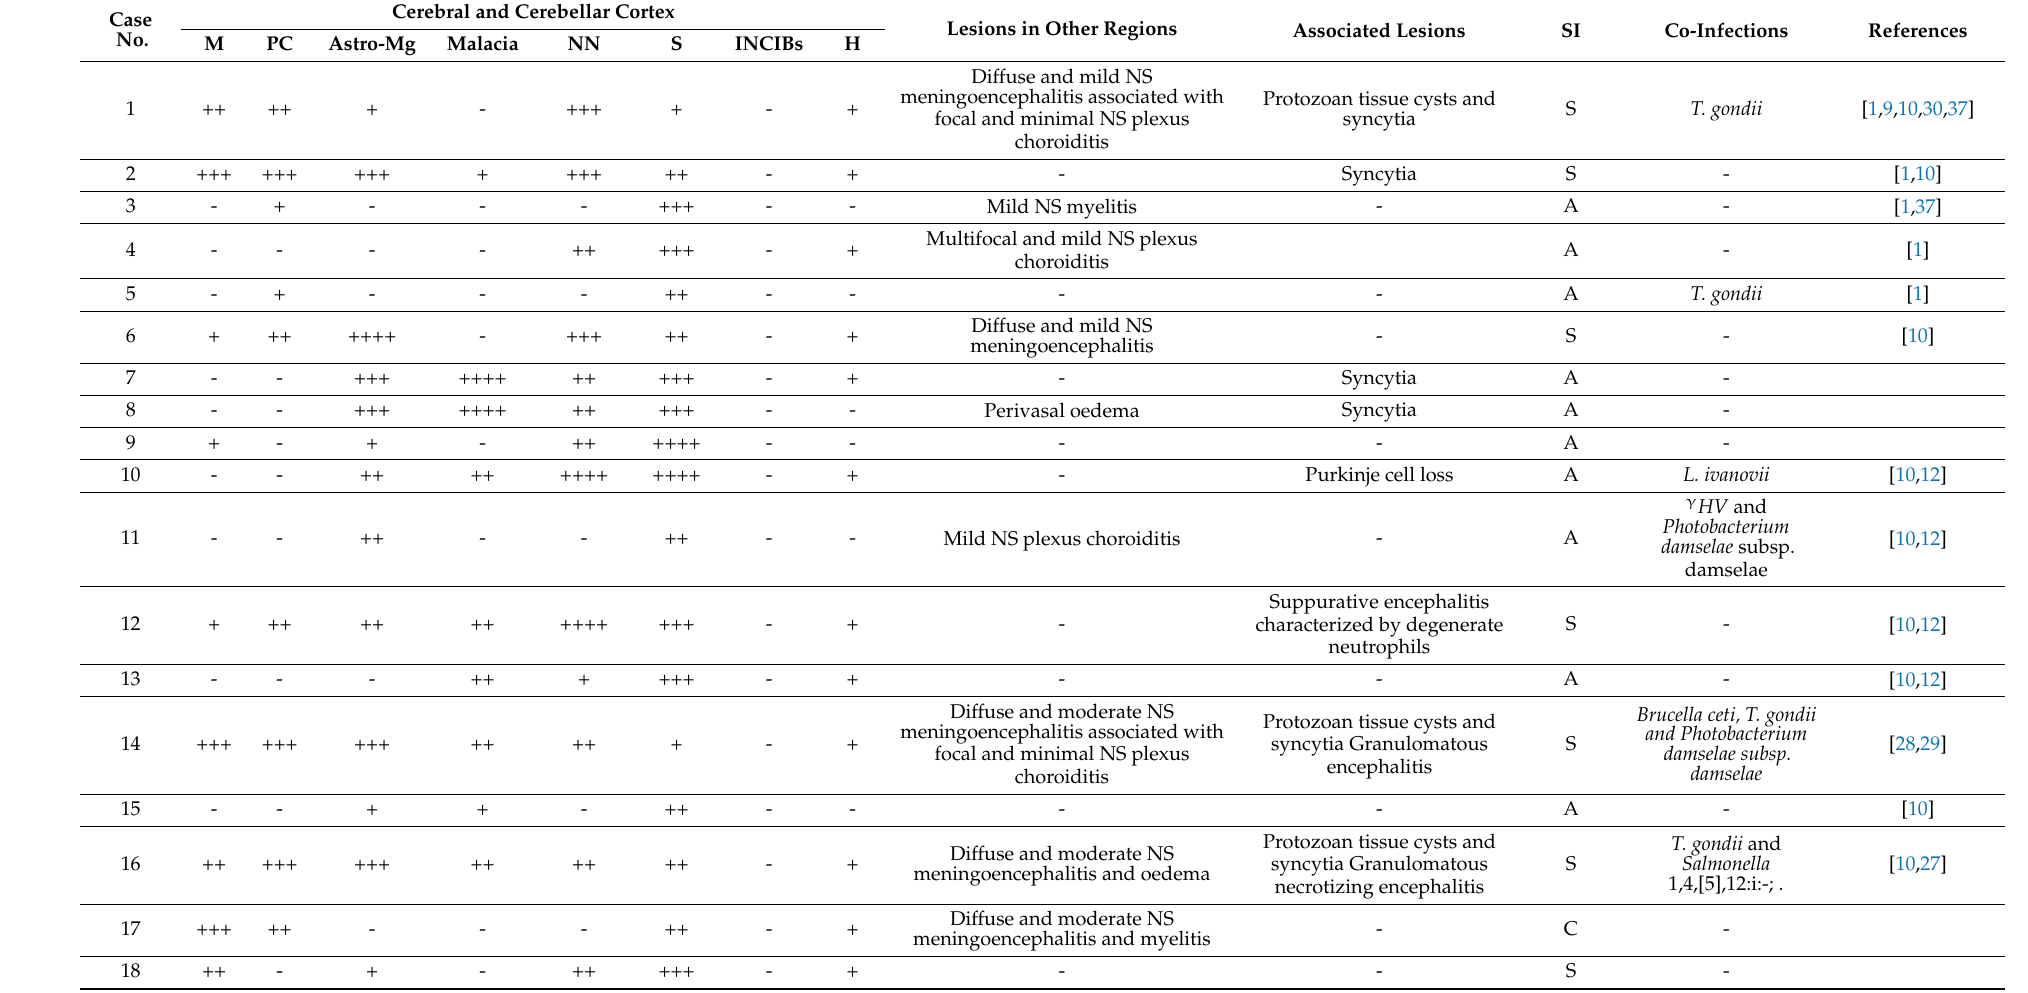
Table 2. DMV-associated lesions in CNS, stage of infection, and co-infection in tissue samples from 31